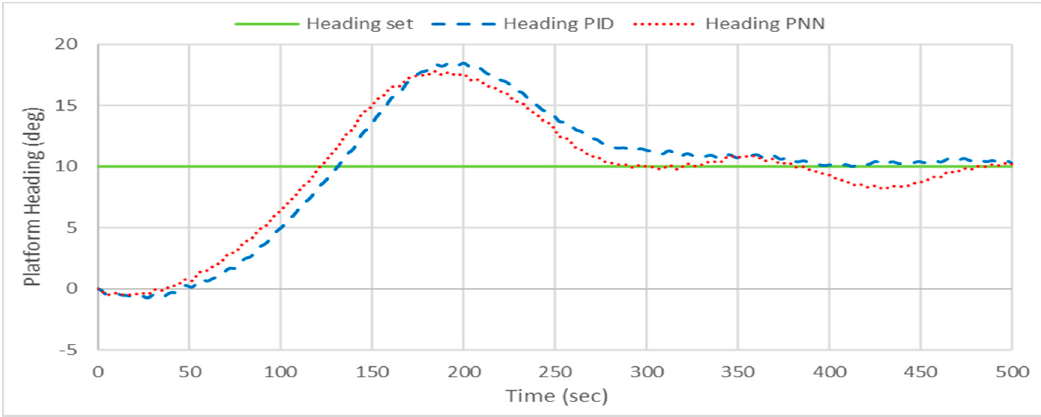
Figure 21. DP simulation with PID and PNN controls showing platform heading (Beam sea).